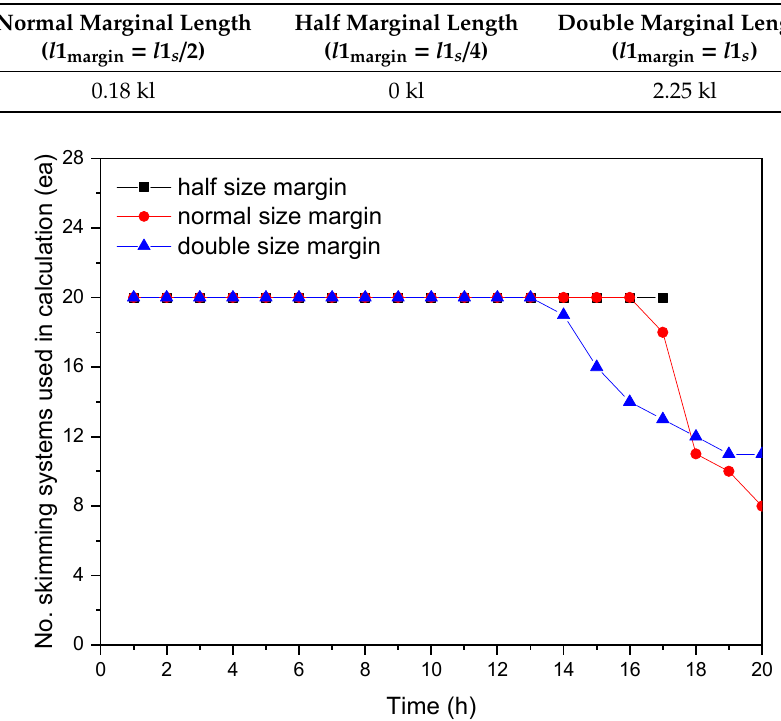
Table 4. Effect of marginal length on the remaining oil volume of unskimmed zones (uncertainty of SNR model for 500 kl spill case study).